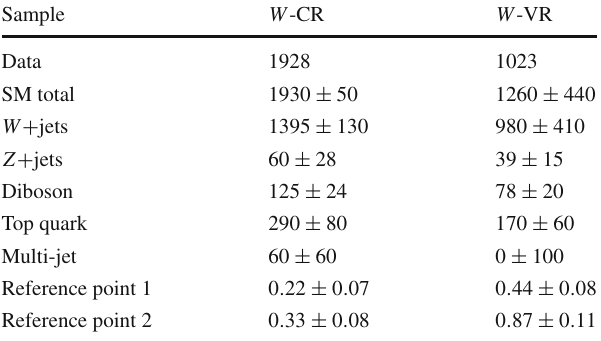
Table 5 Event yields in the W -CR and W -VR. The SM backgrounds other than multi-jet production are estimated from MC simulation. The contribution of W + jets events is scaled with the normalisation factor obtained from the fit. The multi-jet contribution is estimated from data using the OS–SS method. In the W -VR the multi-jet estimation with the OS-SS method yields a negative contribution, which is set to zero. Pre- dictedeventyieldsfortheSUSYreferencepoints(definedinSect.3)are also shown. The uncertainties given are the sum in quadrature of